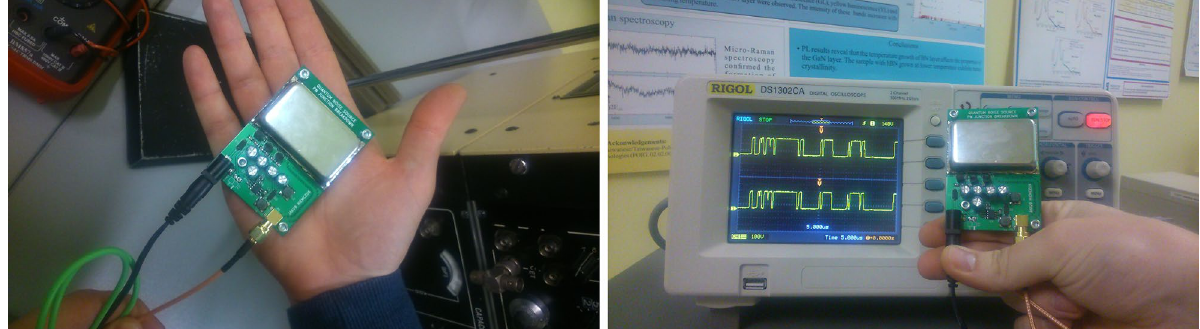
Figure 3. JUR01 quantum random number generator after removing the cover. Generator performance 4Mb/s of random binary code (on the right panel visible signal 0,1 on the oscilloscope